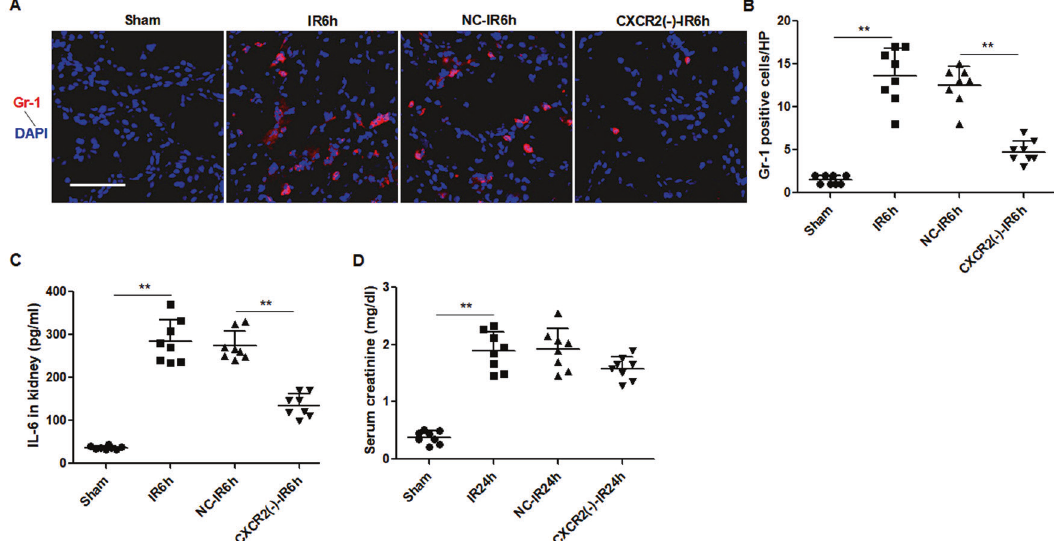
Fig. 6 Inhibition of CXC chemokine receptor 2 (CXCR2) attenuates ischemia-reperfusion (IR)-induced in fl ammation. The mice received intraperitoneal administrations of antagonist of CXCR2 (CXCR2(-)-IR) or vehicle (NC-IR) 1 h prior and 1 h after renal IR. A Immuno fl uorescence staining of Gr-1 in the kidney 6 h after renal IR. Scale bar, 100 μ m. B Quanti fi cation of Gr-1-positive neutrophils. C Concentration of serum creatinine 24 h after renal IR. D ELISA of IL-6 in the kidney 6 h after renal IR. Data represent mean ± SEM. n = 6 – 8. ** p < 0.01.